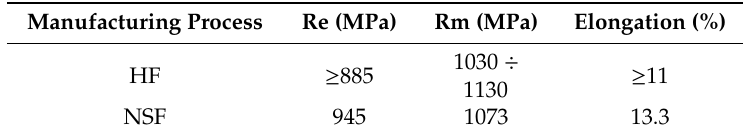
Table 9. Hot forging (HF) requirements for the 42CrMo4 and average mechanical properties obtained by NSF after the same quenching and tempering heat treatment.